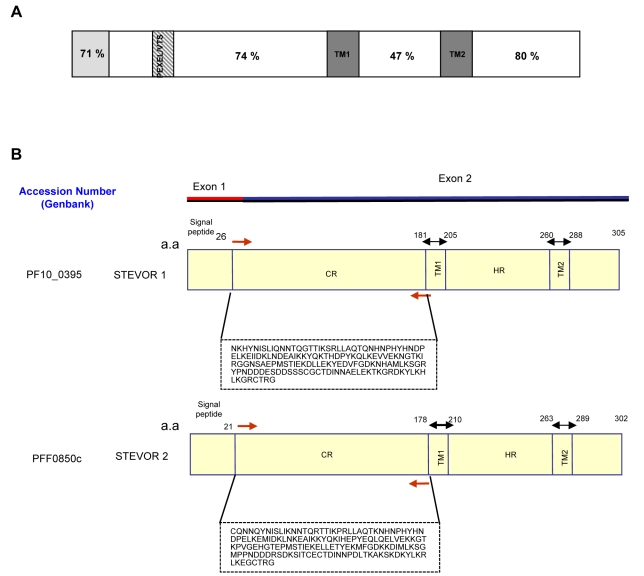
Schematic representation of STEVOR protein.(A) N-terminal signal sequences are shown in light grey, including a canonical signal sequence (encoded by exon 1) and Plasmodium Exported Element/Vacuolar Transport Signal (PEXEL/VTS) sites. Predicted transmembrane domains are shown in dark grey (TM1/TM2). Percentage amino acid similarity between the different regions of all available STEVOR sequences is taken from a review by Kyes et al., [13]. (B) Schematic structure of stevor genes with intron spliced out. Location of signal peptide, predicted transmembrane domains (TM1/TM2), conserved region (CR), and hypervariable region (HR) are indicated by amino acid (a.a) number. Orange arrows indicate primers designed to clone the CR into pET41a (+) vector for generation of stevor antibodies.